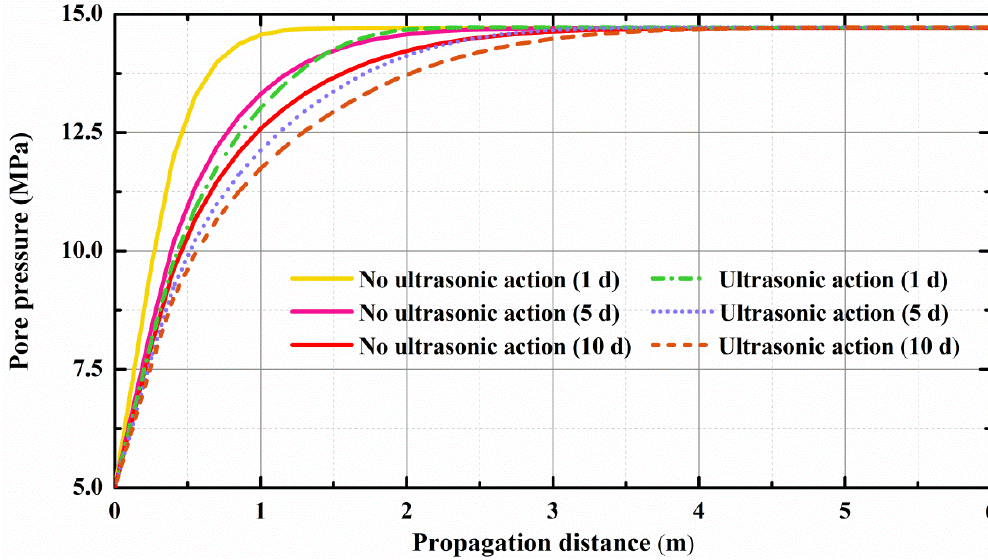
Figure 5. Simulation results of pore pressure changes without and with ultrasonic waves.